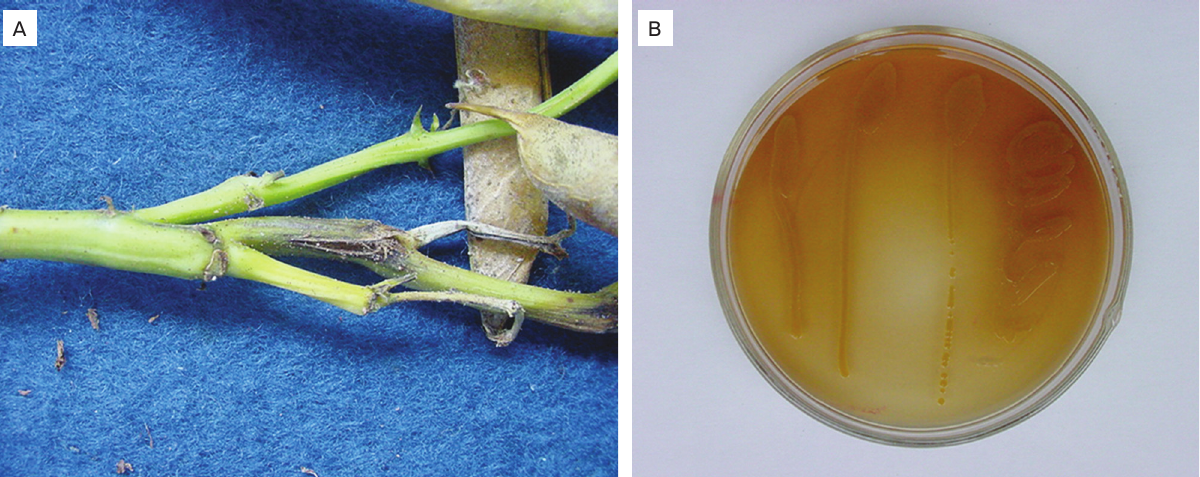
Figure 1. Xanthomonas fuscans subsp. fuscans in bean. (A) Natural infection. Longitudinal section of stem showing vascular discoloration of the vessels; (B) purified colonies onto culture medium. Note the darkening of the